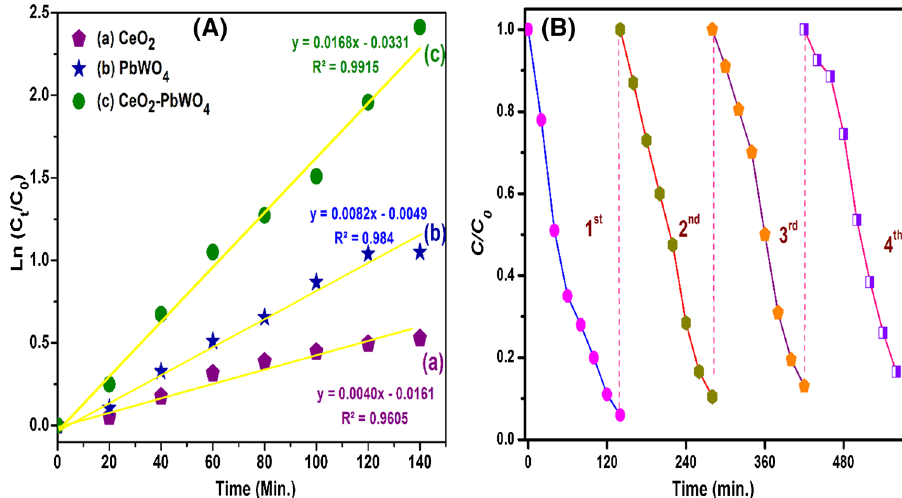
Fig. 9 a Photodegradation lin- ear plot ln (C 0 /C t ) versus time of as-prepared photocatalytic sam-